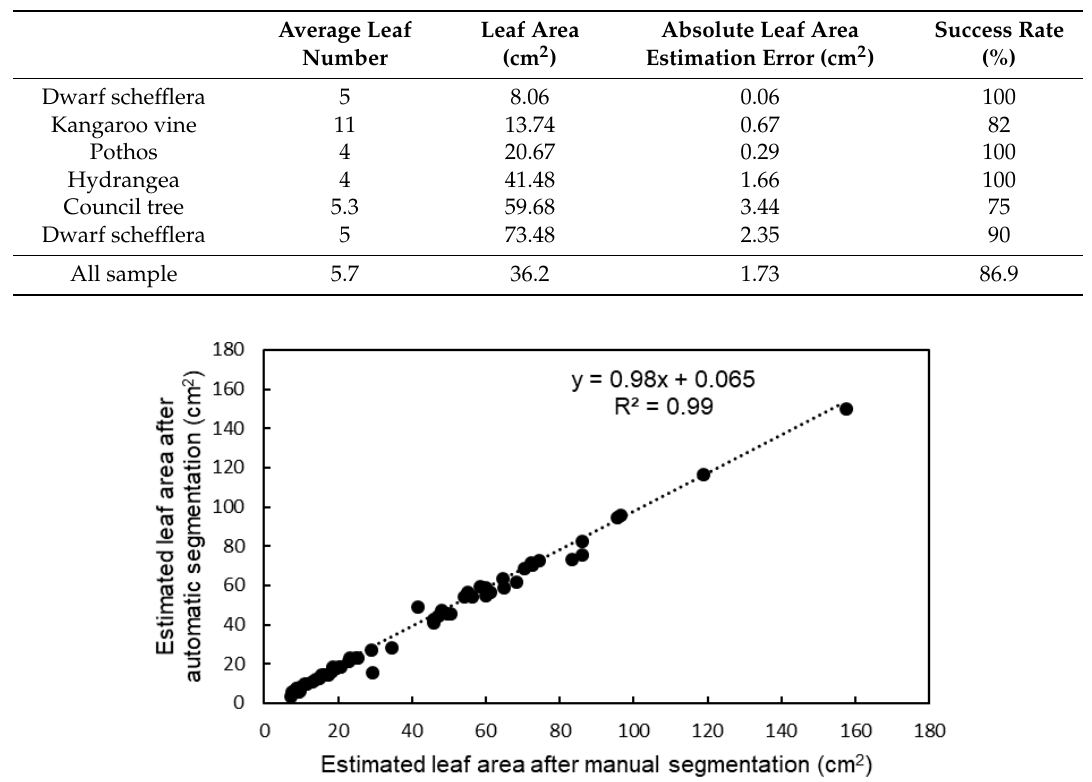
Figure 4. Relationship between leaf area estimates after manual segmentation and those after automatic leaf segmentation.